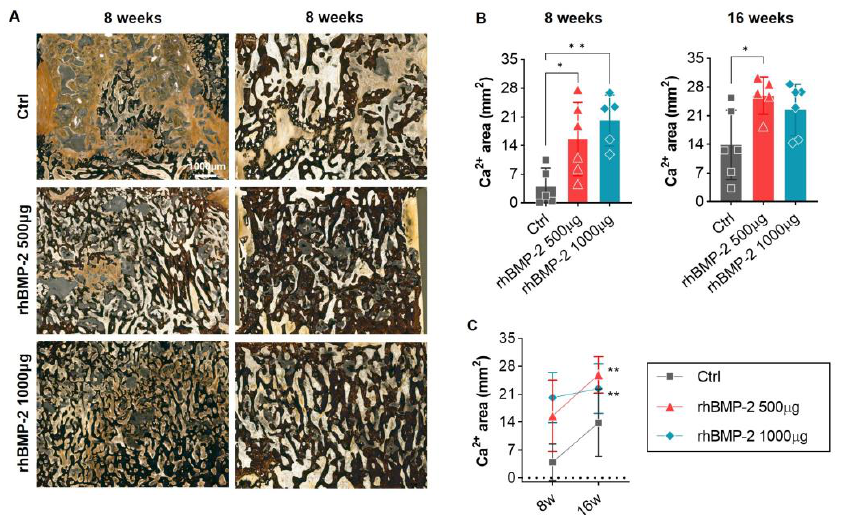
Figure 6. VK staining of calcium-positive mineralized regions. ( A ) Overall and magnified pictures after VK staining inside the cage of the fusion area. ( B , C ) A graph analyzing calcium-positive mineralized areas (stained dark brown). The calcium-positive area increased in proportion to the concentration of rhBMP-2 in the 8-week spine samples. However, the low-concentration group (500 µ g of rhBMP-2) showed high values in the 16-week spine samples. * p < 0.05 and ** p < 0.01 indicate statistically significant differences.